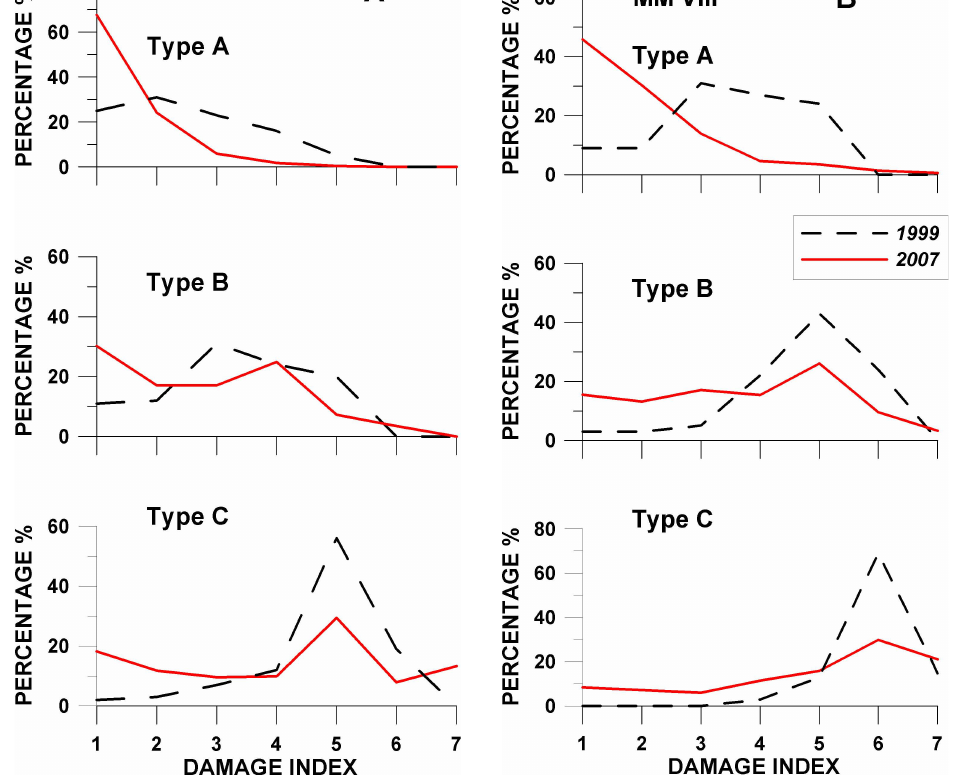
Fig. 10. Comparison between the DPM-2007 and DPM-1999 (Zobin and Ventura-Ram´ırez, 1999) curves. (A) , for intensity MM VII; (B) , for intensity MM